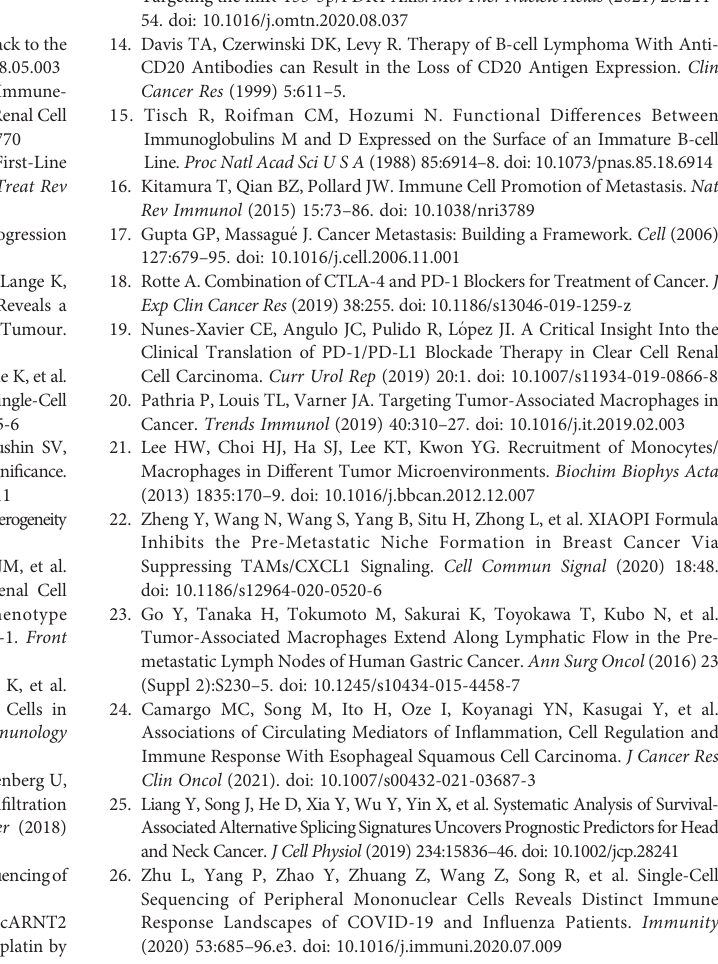
Supplementary Video 1 | 3D-TSNE plots showing the cellular components. (A) 3D-TSNE plot showing cellular components of control biopsies. (B) 3D-TSNE plot showing cellular components of ccRCC biopsies. Supplementary Figure 1 | Gene-Set-Enrichment Analysis of B Cell Subpopulations. (A) Dot plot showing the biological features of three B cell subpopulations. (B) Analysis of gene-concept-network in B cell subpopulation: B cell (MARCH2). (C) Analysis of gene-concept-network in B cell subpopulation: B cell (B2M). (D) Analysis of gene-concept-network in B cell subpopulation: B cell (DTWD1). Supplementary Figure 2 | Con fi rmative Analysis Of Plasma Cells. A violin plot showing the expression levels of MKI67 between plasma cell subpopulations. Supplementary Figure 3 | Gene-Set-Enrichment Analysis of Plasma Cell Subpopulations. (A) Analysis of gene-concept-network in plasma cell subpopulation: plasma cell (RPS12). (B) Analysis of gene-concept-network in plasma cell subpopulation: plasma cell